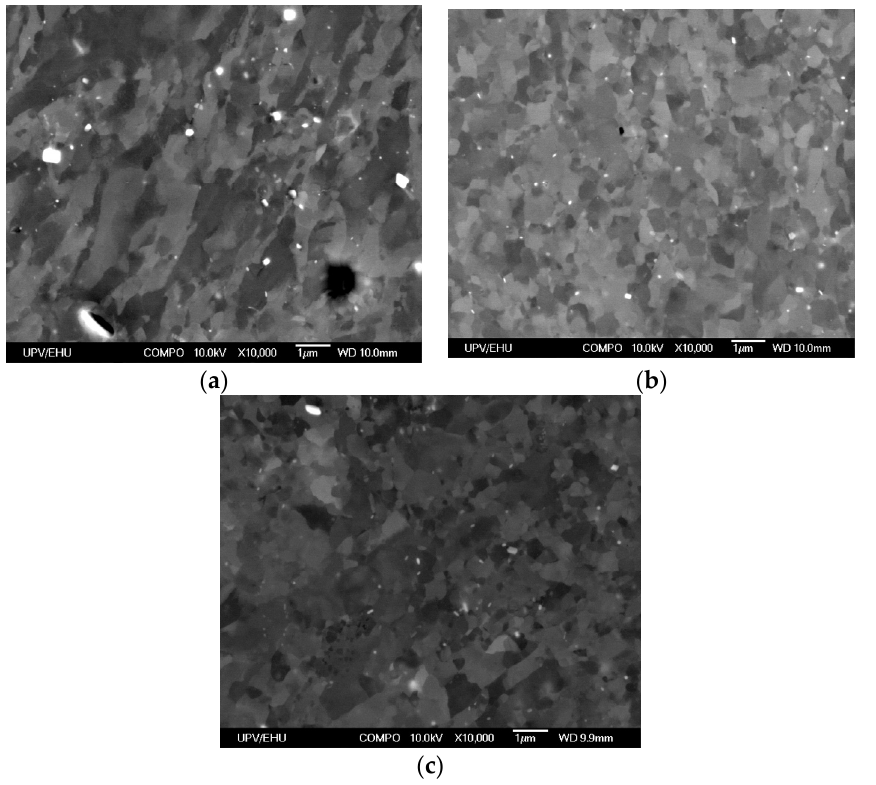
Figure 11. SEM micrographs of different AA5754 states forged at 250 °C: ( a ) AA5754 at N0; ( b ) AA5754 at N2; ( c ) AA5754 at N2 + flash.